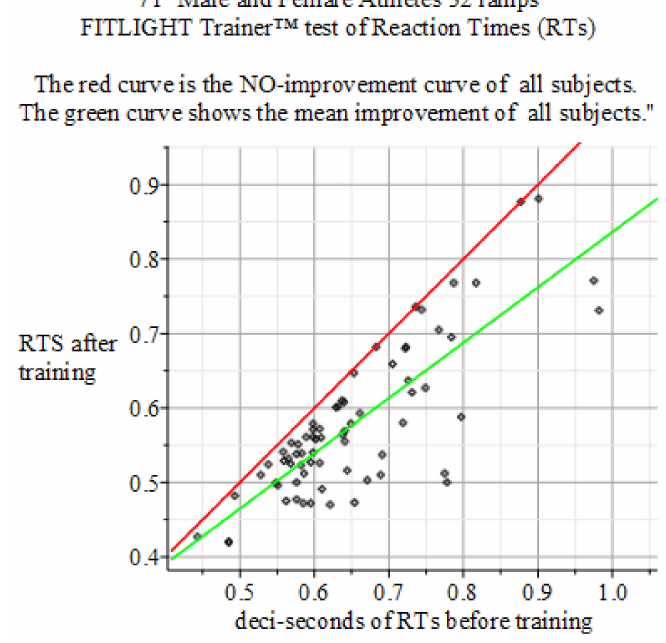
Figure 5. Summary of the above result. Reaction Times: 32 lamps FITLIGHT Trainer™ equipment. Sample size of 71 men and women. Baseline sample mean 0.650 s, σ = ± 0.1075 and Final mean 0.577 s with σ = ± 0.0988966. P -value 0.0000383454. Result: Hypothesis of NO-Effect of training is: Rejected.